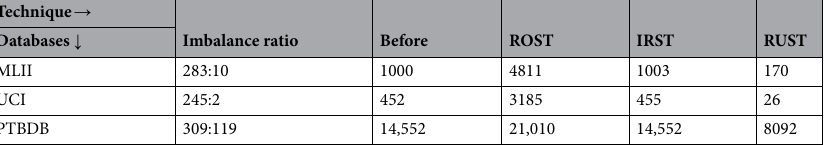
Table 6. Total number of samples before and after applying resampling techniques in various Databases used for